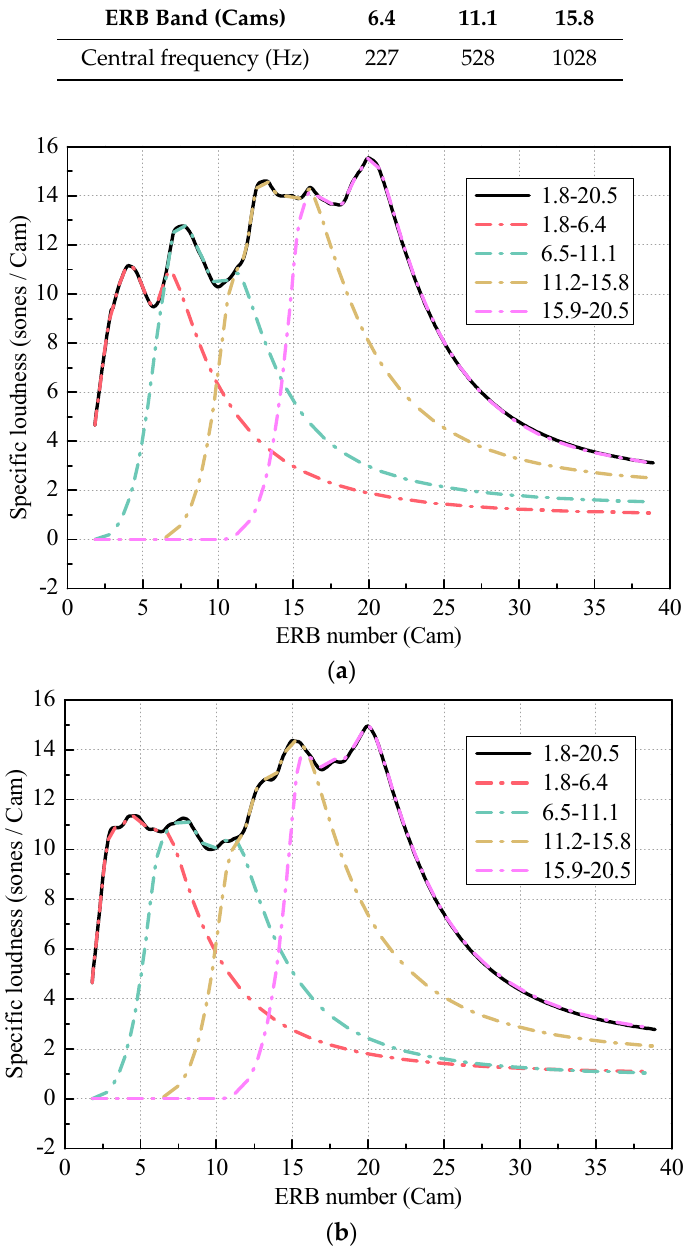
Figure 16. Specific loudness curves of sub-bands before and after improvement. ( a ) Before improvement. ( b ) After improvement. Table 5. Loudness and sharpness of Table 4. Central frequencies of cut-off points of ERB bands.